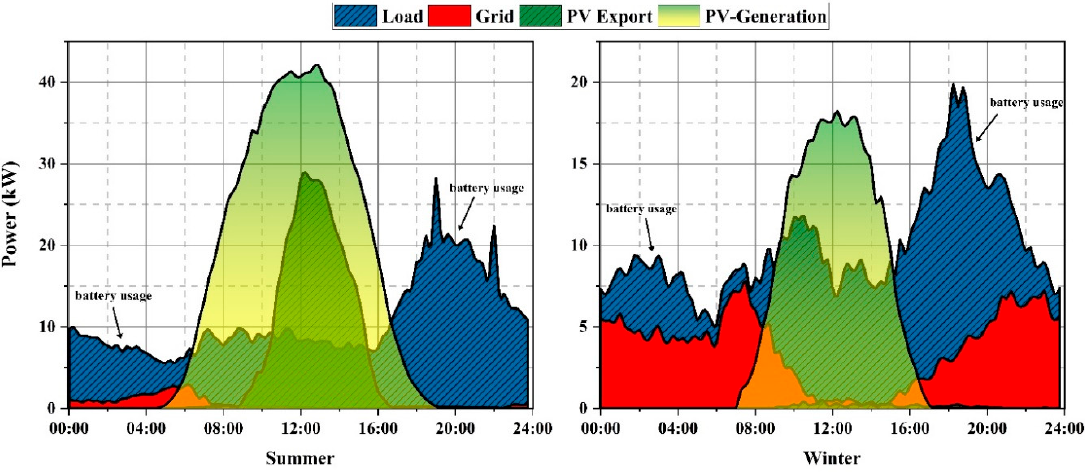
Energies 2020 , 13 , x FOR PEER REVIEW Figure 4. Seasonal load profile for Evermore. Figure 4. Seasonal load profile for Evermore.